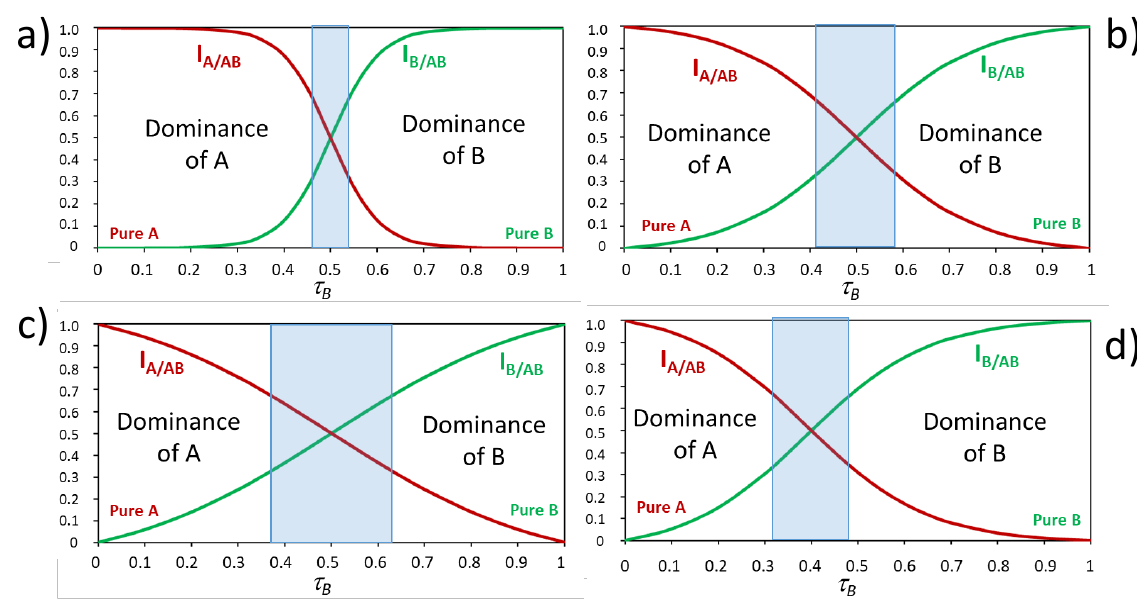
Figure 3. Idealised representations relating the intensity of the perceived odours in a binary mixture of non-blending odorants to its odour composition. The plots a–c represent the steepest (( a ), upper left), mean (( b ), upper right) and the flattest (( c ), left down) sigmoid functions found experimentally with a perfectly symmetric dominance, respectively. The right-down plot ( d ) represents the strongest asymmetry reported. Adapted with permission from ref. [29].